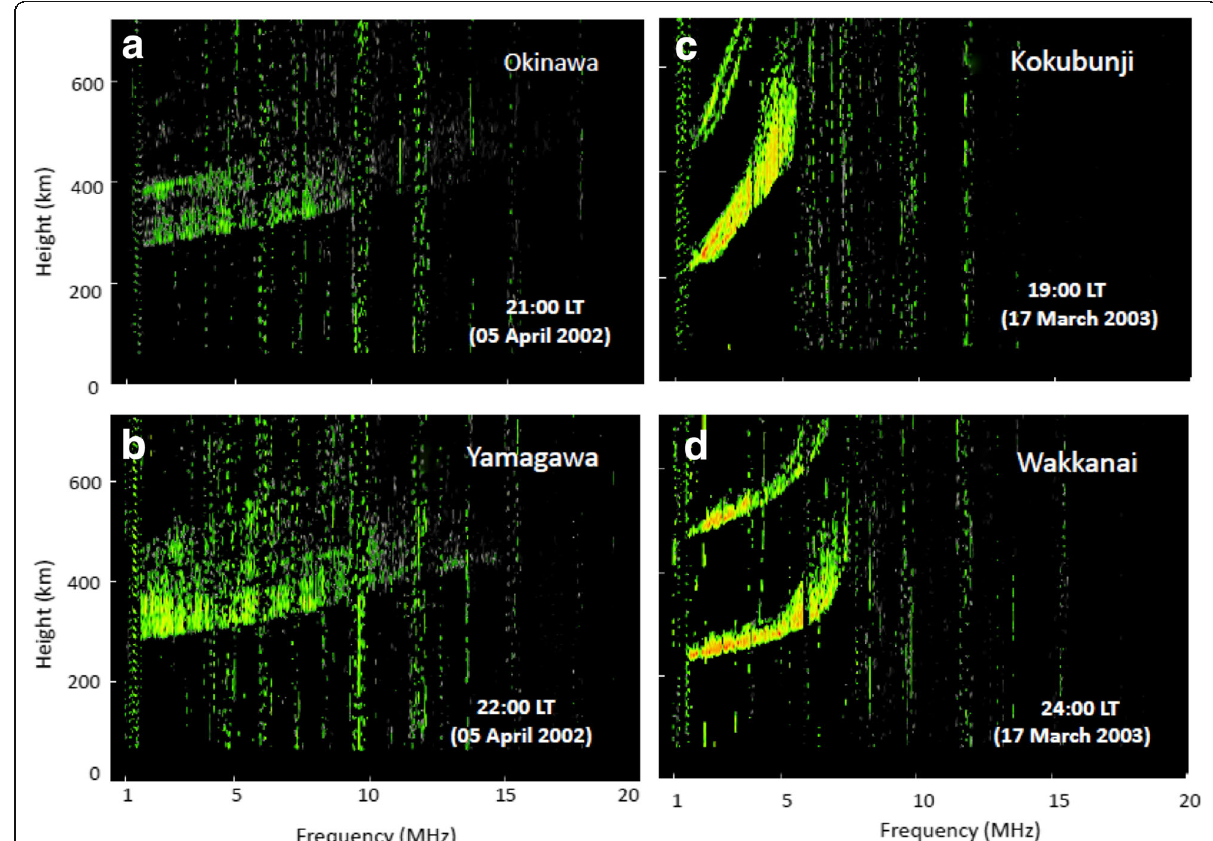
Fig. 1 Sample ionograms showing spread-F at a Okinawa (26.3° N, 127.6° E; 15.3° N mag. lat.) and b Yamagawa (31.2° N, 130.6° E; 21.2° N mag. lat.) on 05 April 2002 (Ap = 4) and c Kokubunji (35.7° N, 139.5° E; 26.5° N mag. lat.) and d Wakanai (45.4° N, 141.7° E; 36.5° N mag. lat.) on 17 March 2003 (Ap = 42) in Japan. Spread-F is range type at Okinawa and Yamagawa (low latitudes) and frequency type at Kokubunji and